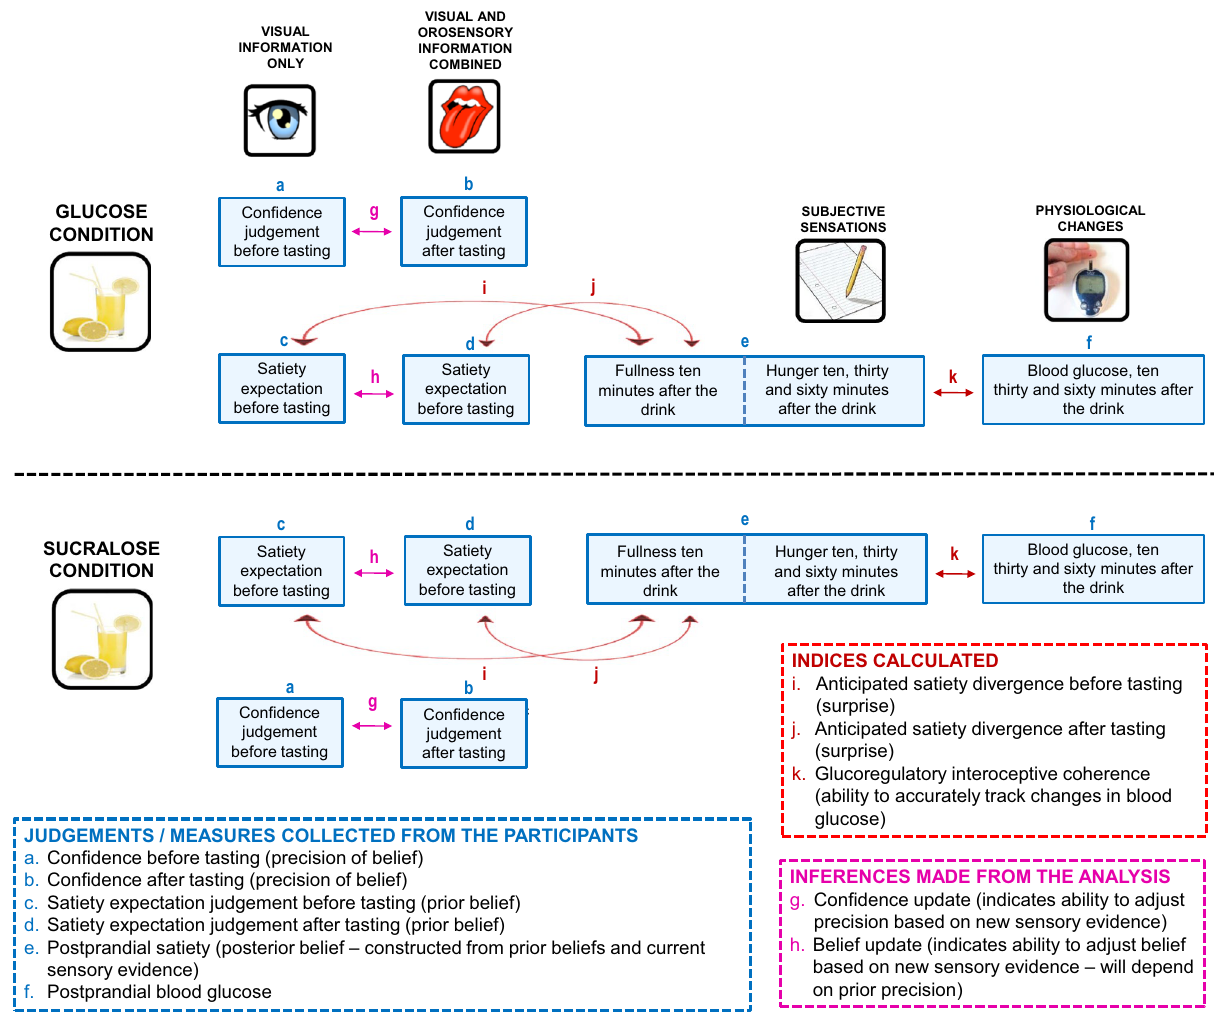
Figure 3. A schematic illustration of the procedure and the derived interoceptive